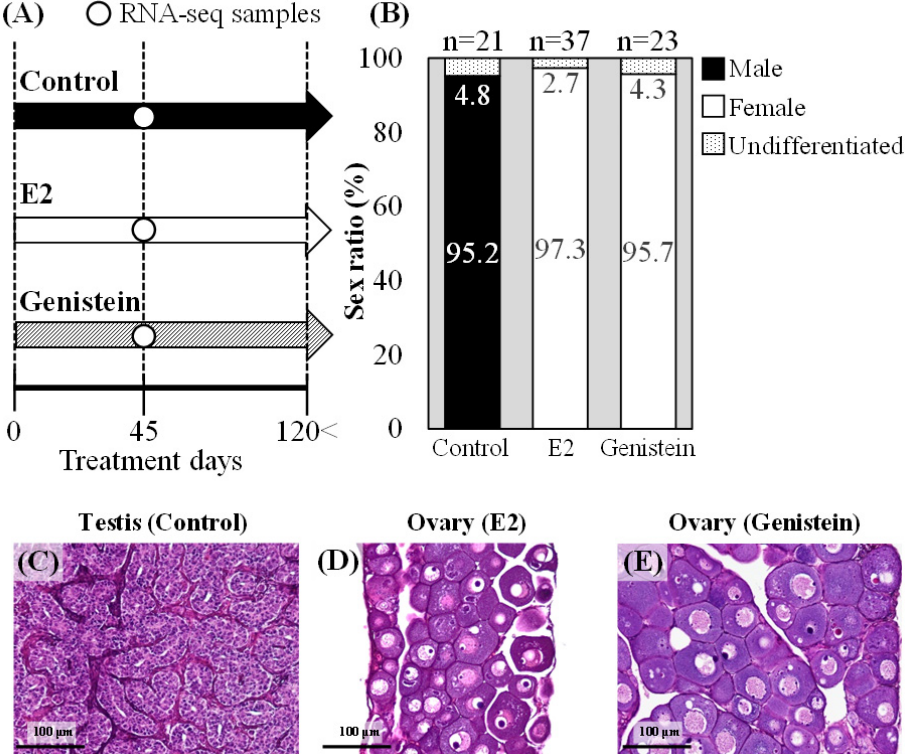
Figure 4. Effects of genistein and estradiol-17 β (E2) in Japanese eels. ( A ) Time course of the feminiza- tion experiments in the eels fed an E2- or genistein-treated diet or untreated diet (control). ( B ) Sex ratios in the eels fed an E2- or genistein-treated diet or untreated diet (control). ( C – E ) Histological sections of gonads after hematoxylin and eosin staining: control testis ( C ), E2-treated eel ovary ( D ), and genistein-treated eel ovary ( E